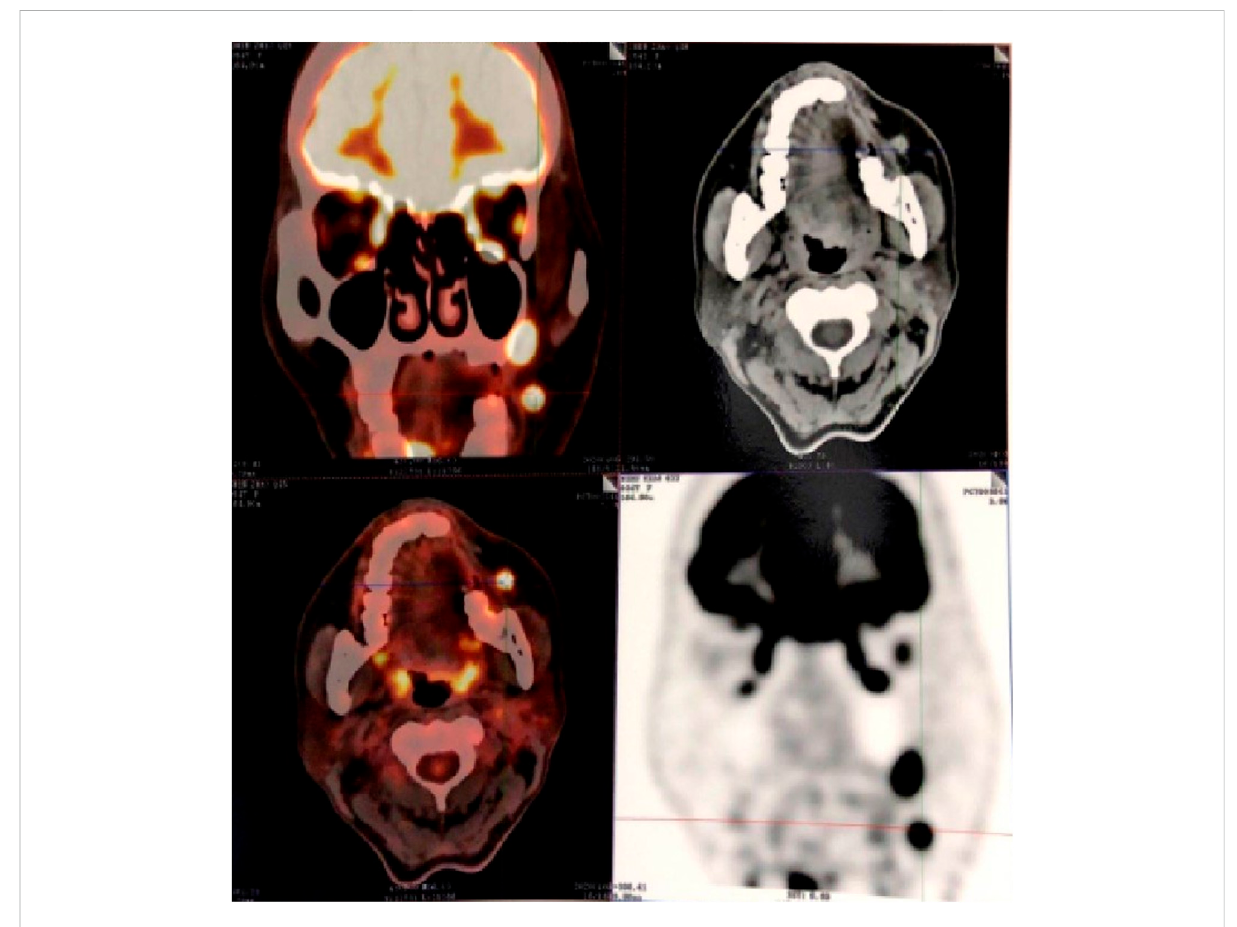
FIGURE 2 PET-CT axial view shows metabolic hyperactivity of the lymph node mass on the left